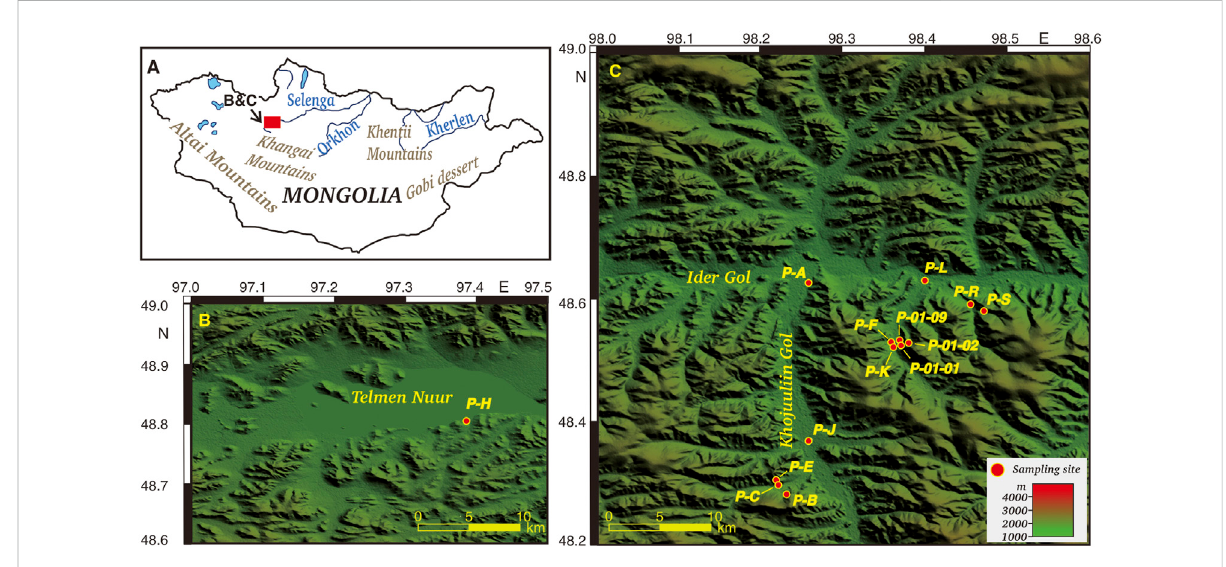
FIGURE 1 Study area and sampling sites. The red block in (A) shows the study area, including Telmen Nuur (B) and Tosontsengel (C) . The Source of the digital elevation model is